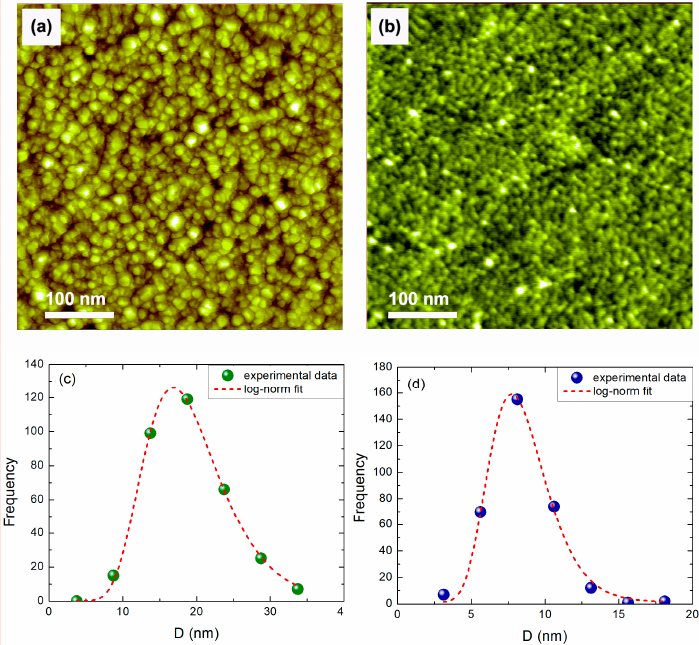
Figure 1. AFM images of ( a ) 13.5 nm and ( b ) 4 nm thick NiO films. The image size is 500 × 500 nm 2 . Grain diameter D size distributions for the ( c ) 13.5 nm and ( d ) 4 nm thick NiO films.